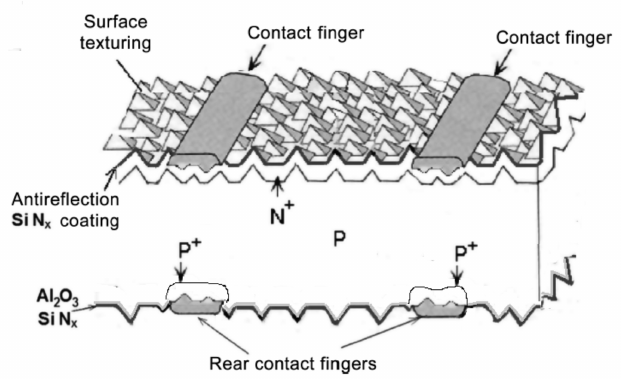
Figure 13. Bifacial cell